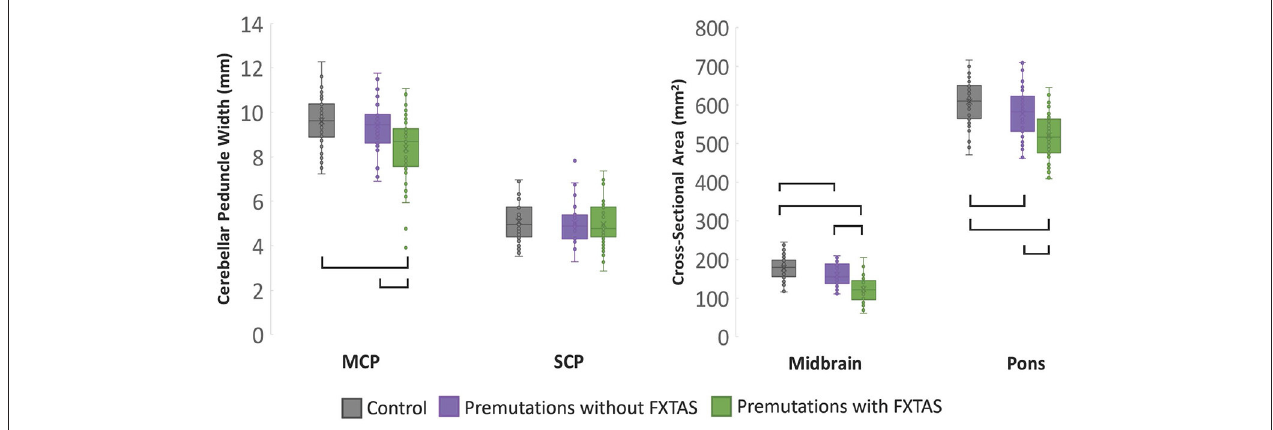
FIGURE 2 | Cross-sectional analysis of MRPI measurements at time 1, with age as a covariate. Brackets represents group differences where p < 0.05 using post-hoc Bonferroni correction.